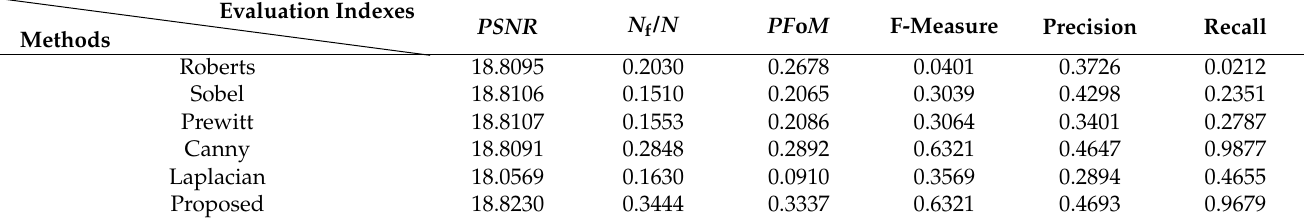
Table 3. The evaluation indexes scores of multiple edge detection methods for the fused